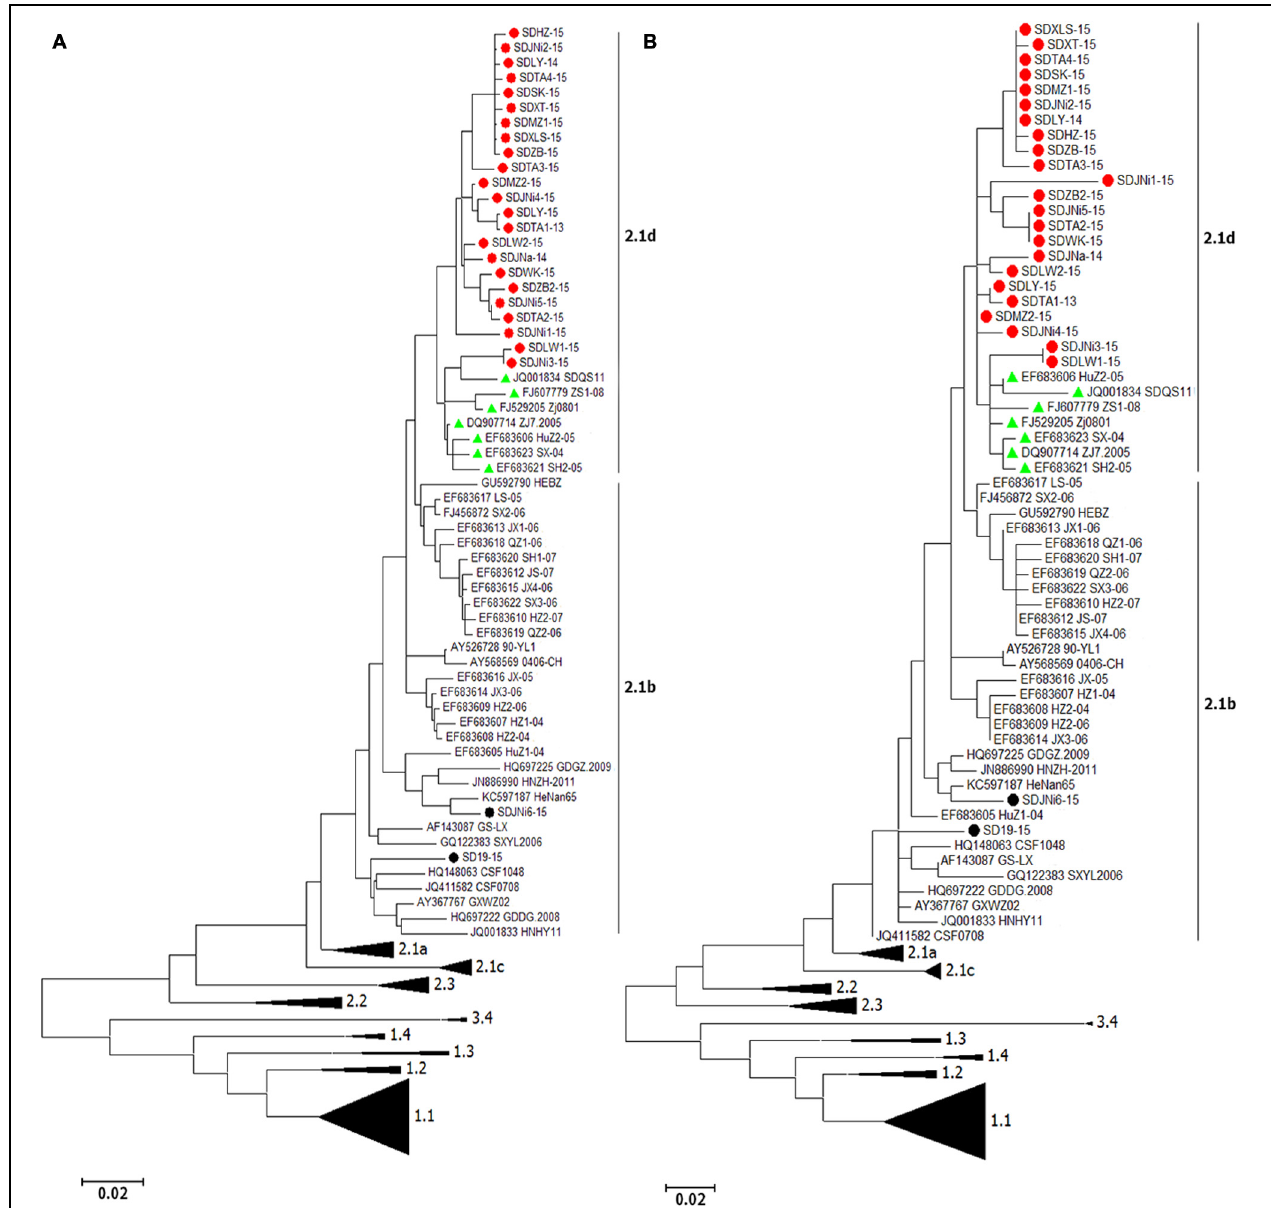
FIGURE 2 | Phylogenetic analysis of different genomic regions of the 25 new isolates and 122 reference strains. (A) Full-length E2 gene sequences. • (B) Partial E2 gene sequences. 23 newly isolated strains (indicated by ) accompanied with seven references strains (indicated by (cid:2) ) were clustered